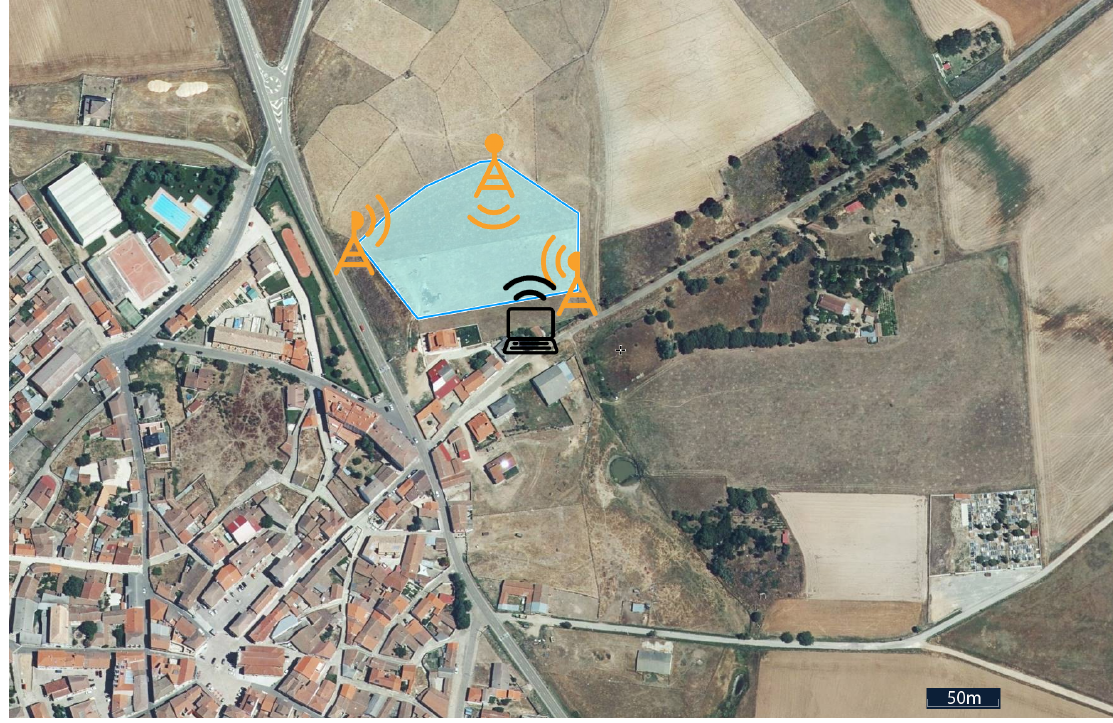
Figure 4. Location where the case study was